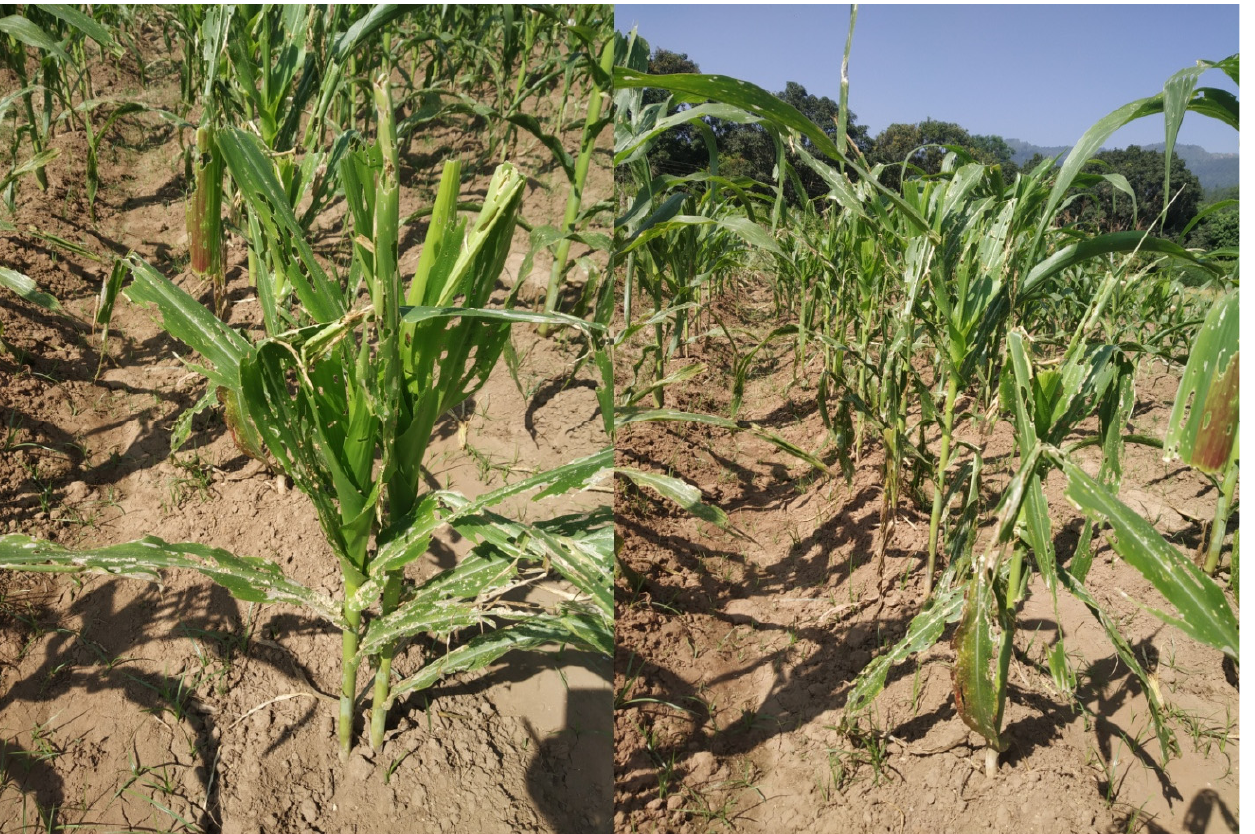
Figure 2. Fall armyworm damage observed in maize trials during season-2. The photo was taken between 41 and 47 days after sowing. The maize plants were continuously under infestation right from the seedling emergence until fully exertion of the tassel, pesticide application was in-effective, there was no maize cultivation near the study location. Plants were under physiological stress, thus vegetative growth was inferior compared to the normal season (season-1).